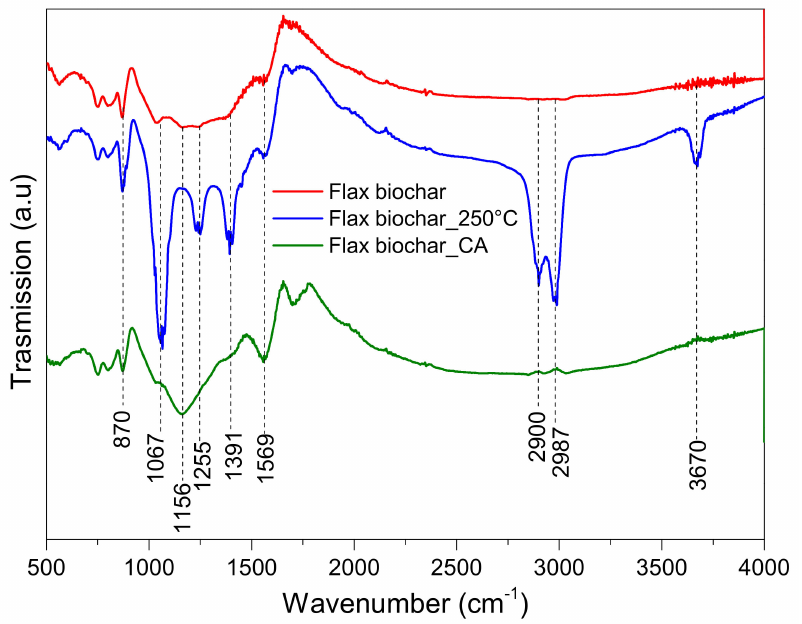
Figure 8. FTIR spectra for flax biochar before and after